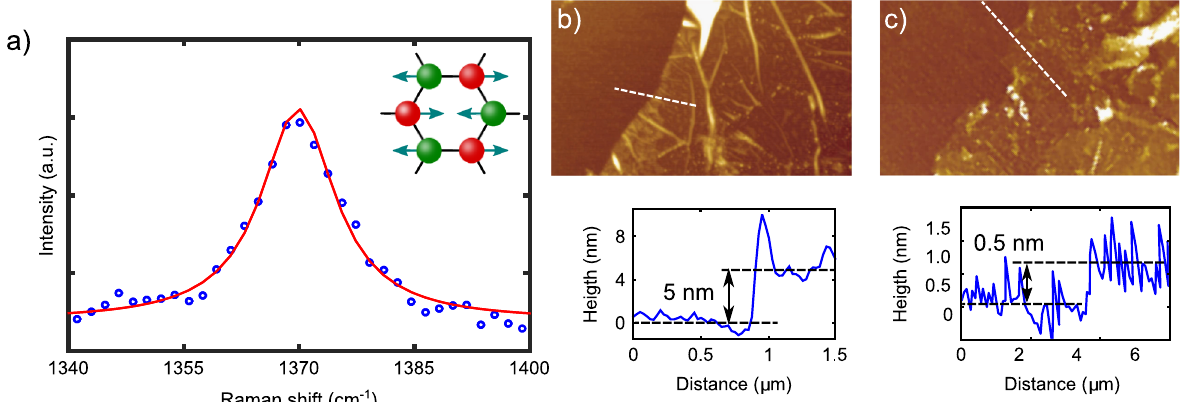
Fig. 2 Single-layer h-BN characterization. a Raman spectroscopy is used to determine the single-layer nature of the suspended material. As reported in ref. 9, we fi nd a peak at 1370 cm − 1 that corresponds to a monolayer h-BN. Inset Vibrational mode of a h-BN ring for that Raman frequency. b AFM height image of a h-BN material edge before cleaning. The obtained thickness (5 nm) is larger than that expected for single- layer (0.44 nm). The material is covered with polymer contamination that can be removed by oven annealing at 450 °C in air and ozone as seen in c , where areas of 0.5 nm thick are found